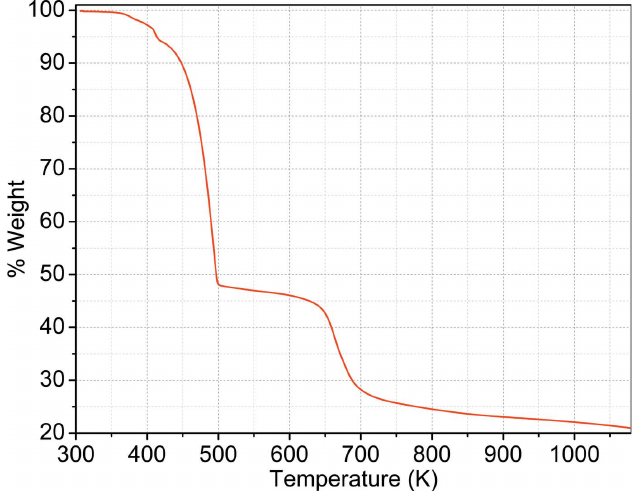
Figure 8 TGA curve of the title compound 1 .